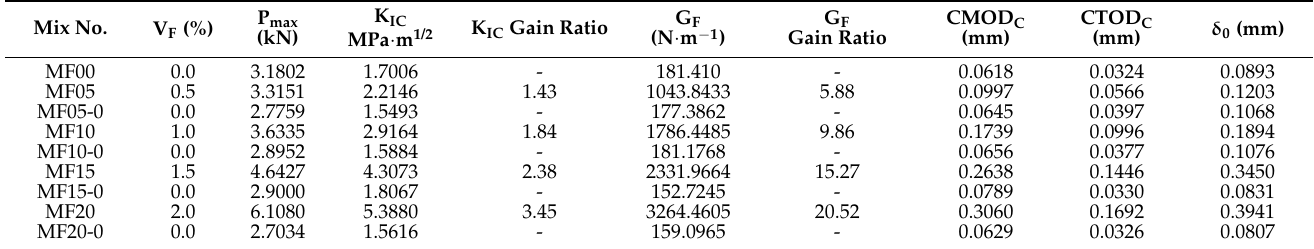
Table 2. Testing results for the fracture parameters of SFRC and ordinary concrete.